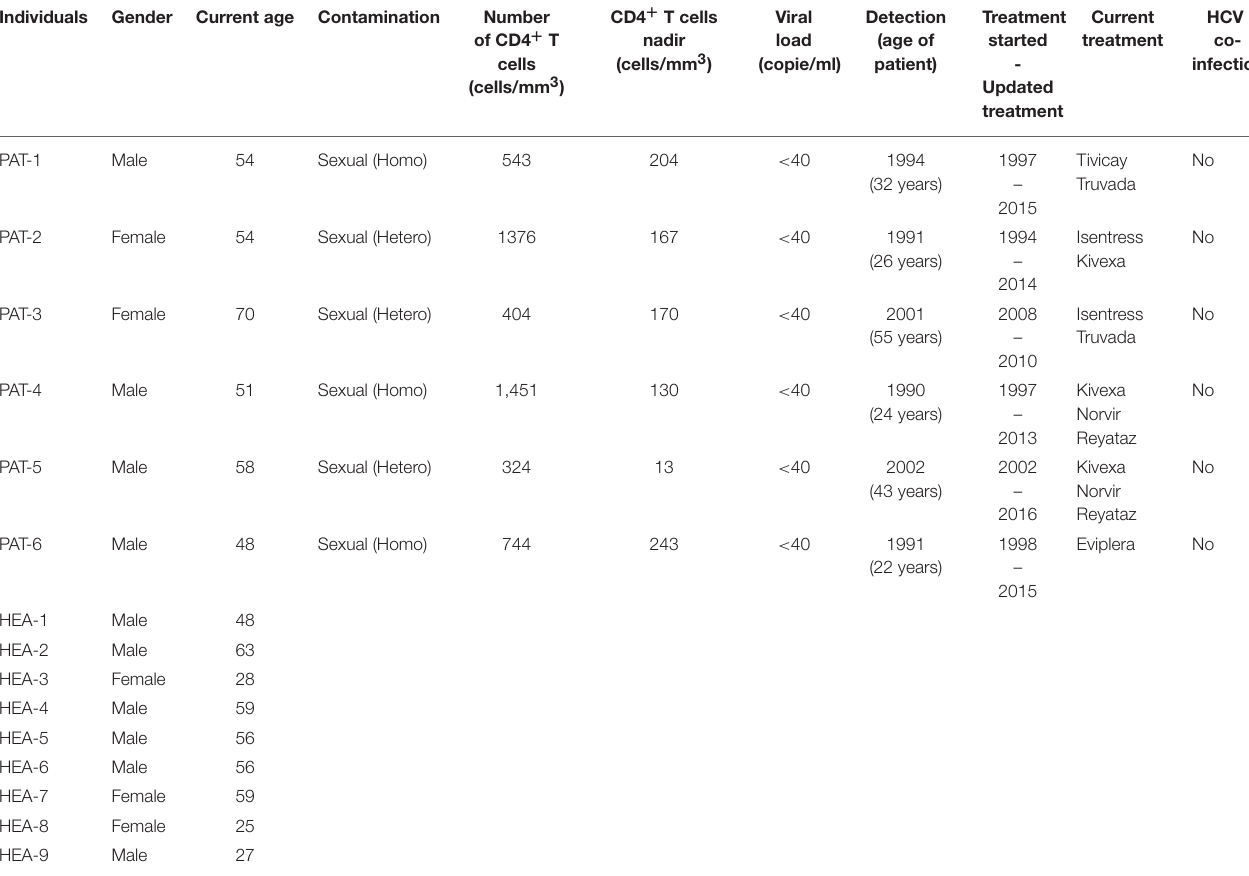
TABLE 1 | Characteristics of HIV-infected patients and healthy donors. Individuals Gender Current age